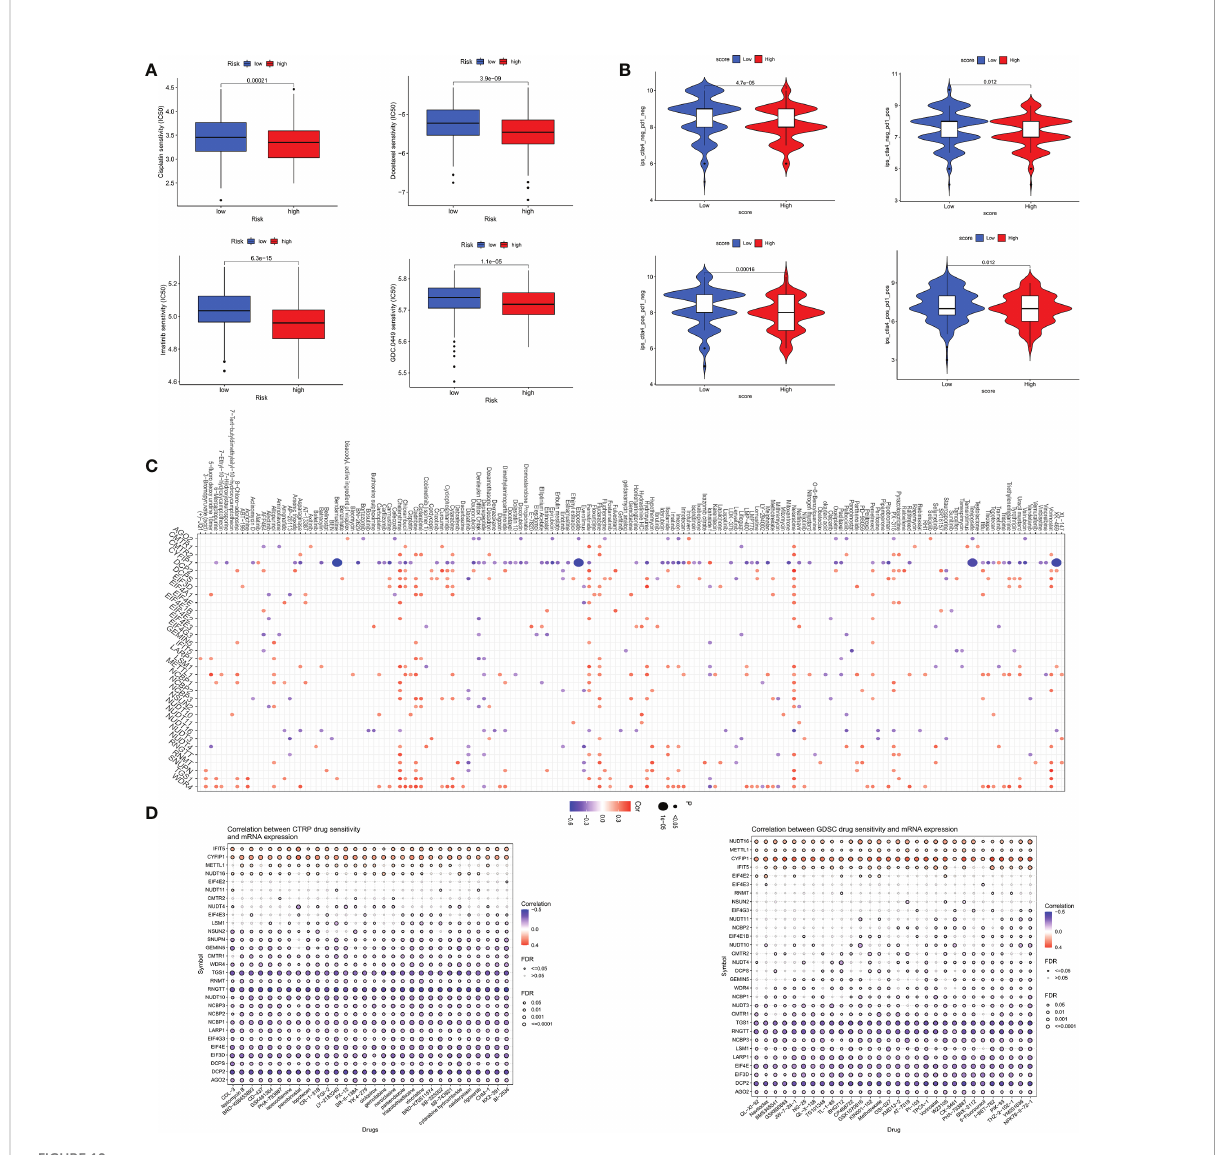
FIGURE 10 (A) Sensitivity analysis of high- and low- risk groups to four common GC therapeutic agents. (B) sensitivity analysis of high- and low- risk groups to immune checkpoint blocking therapy, such as anti-PD-1 and anti-CTLA4. Sensitivity analysis of m7GRGs to some antitumor drugs (C) and non-immunotherapeutic drugs (D) . PD-1, programmed death-1; CTLA4, Cytotoxic T lymphocyte-associated